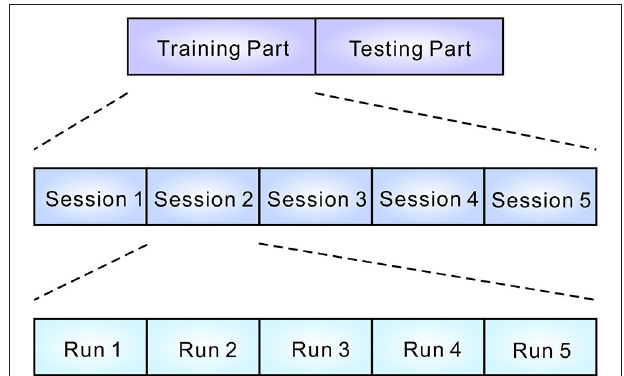
FIGURE 1 | Structure of the experiment. EEG data were recorded during the training and testing parts. Each part consisted of five sessions. In every session, five runs were conducted. Participants were asked to select a sound during a run (see Figure 2 ).